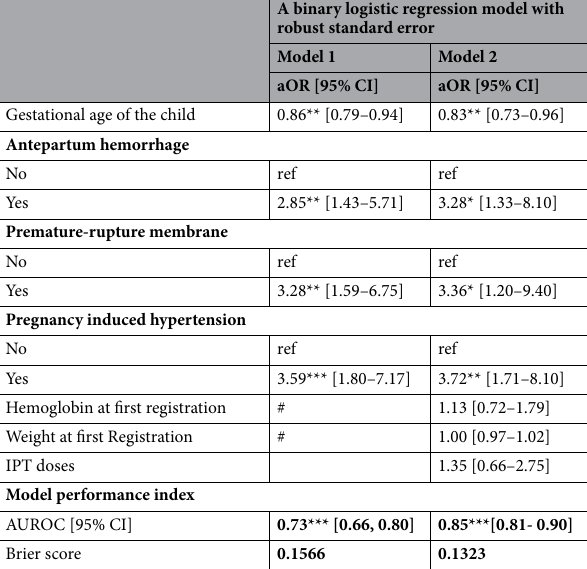
Table 5. Quantifying the effect of fetal and maternal factors on intrapartum stillbirth. ref reference category. OR Odds Ratio. P -value notation: ***: p < 0.001. **: p < 0.01. * p < 0.05. CS caesarian section. SVD spontaneous vagina delivery; #: Not included in model 1. IPTp Intermittent Preventive Treatment for pregnant women, AUROC Area under the Receiver Operating Characteristics